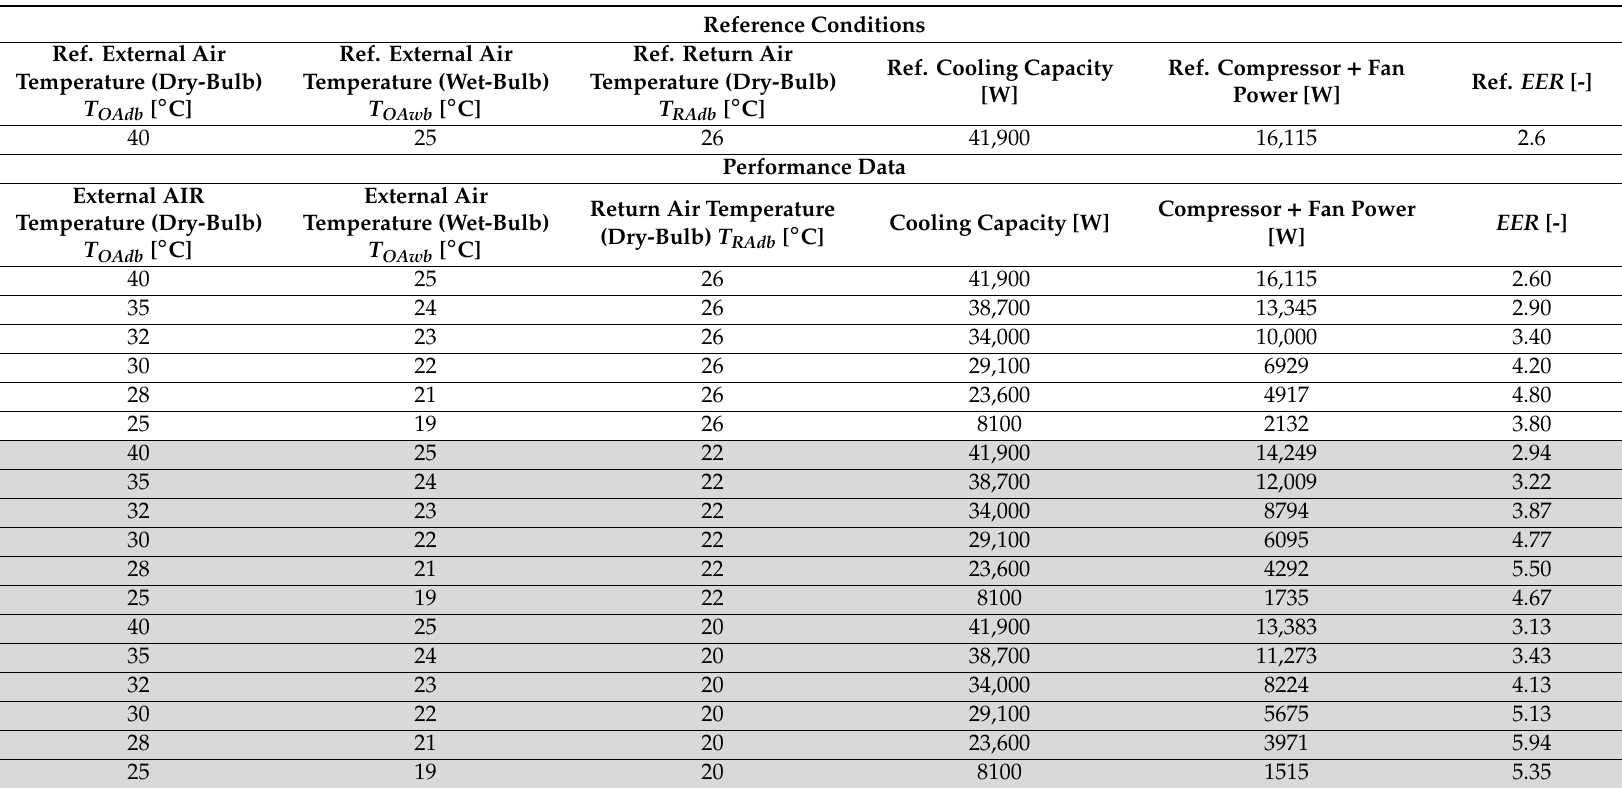
Table 5. Datasheet values in cooling mode for present study analyses (manufacturer data in gray). Air handling unit model Zephir CPAN-XHE3 (air flow 4600 m 3 / h, supply humidity ratio 11 g vap / kg air